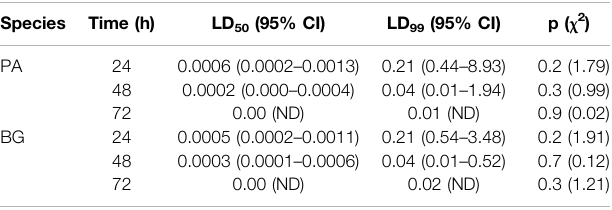
TABLE 3| Mortalityeffect on P.americana and B.germanica speciespost24,48, and 72 h after 1 h deltamethrin